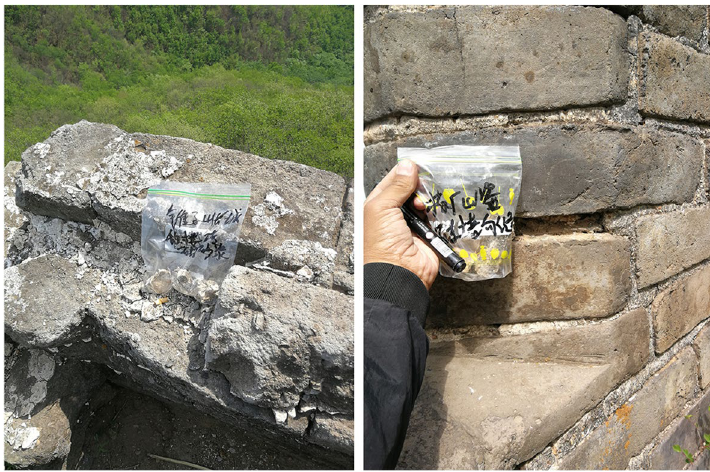
Fig. 14 Sampling of lime mortars. Left: bedding mortar. Right: pointing mortar from a double struck joint (Source: